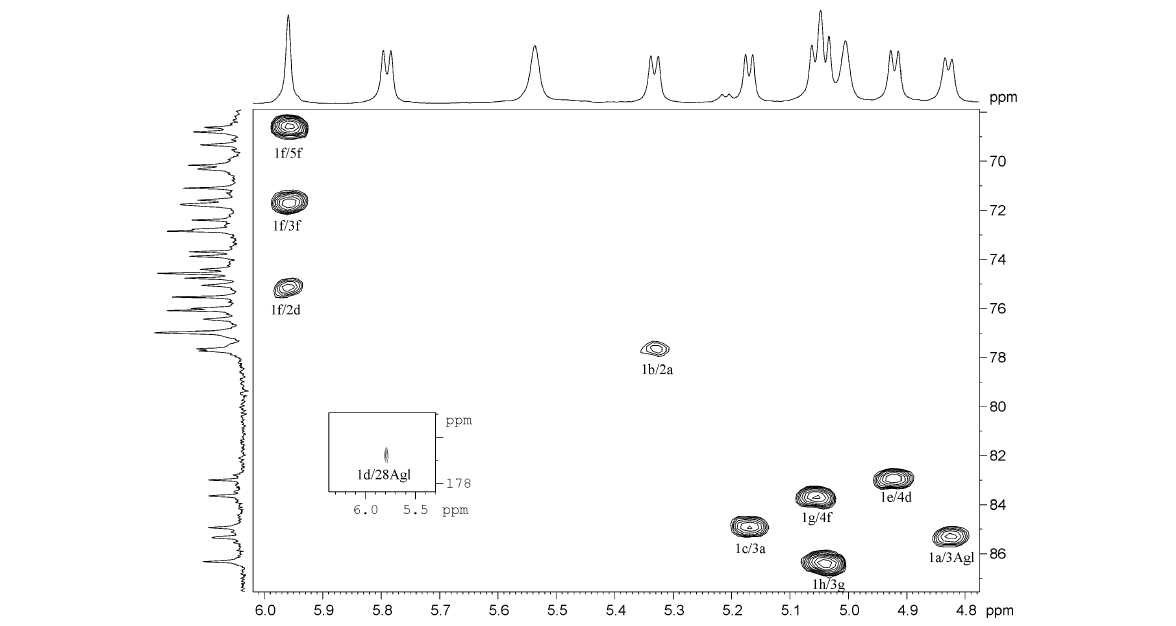
Figure 4: Part of the HMBC spectrum of compound 1 . 1 H and 13 C NMR spectra are shown along the horizontal and vertical axes, respectively. Arabic numerals before a slash refer to protons and after a slash refer to carbons in sugar residues denoted by letters, as shown for compounds 1 and 2 .